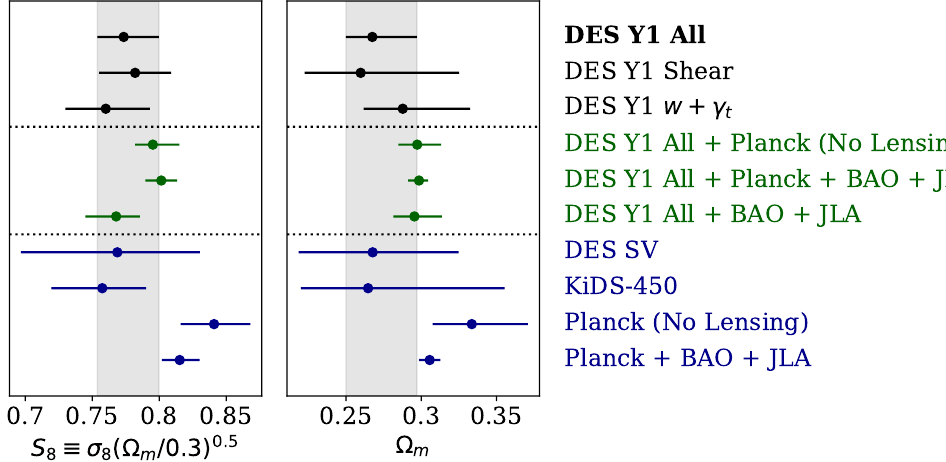
Figure 4. Results for S 8 and Ω m within Lambda Cold Dark Matter ( Λ CDM). Dark Energy Survey (DES) Y1 refers to the first year of observations of DES, DES SV to the Science Verification analysis, KiDS-450 to the weak lensing analysis from the Kilo Degree Survey [8], Planck and JLA to CMB and supernova Ia analyses, respectively. From Abbott et al.